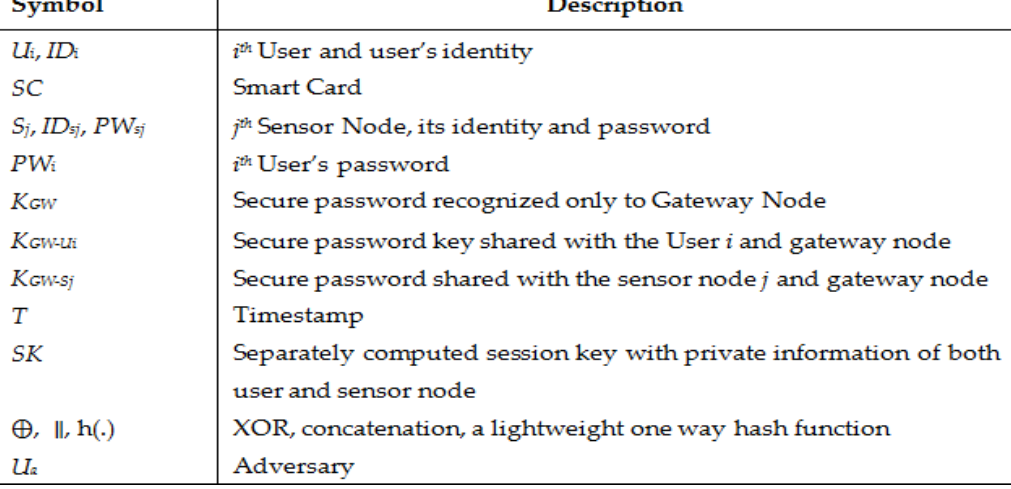
Figure 2. Registration phase of Singh et al.’s scheme. 3.1.1. Registration Between User and Gateway Identity ( ID i ) and secure password ( PW i ) are provided to every user. User identity and password hash value are saved in the gateway node. At first, the gateway selects a random key K GW-U . With this key, GW can communicate with the user. The gateway fur- ther selects a different key K GW-S . With this particular key, GW can communicate with sensor nodes. The procedure for this phase is as follows: Step-1: User U i selects a random number r i and computes P i = h ( r i || h ( PW i )). Step-2: User generates time stamp Ts 1 and sends { P i , ID i , Ts 1 } to GW through a pro- tected channel. Step-3: Following the received message, the gateway verifies the legitimacy of a time stamp. If | T S 1 − T c | < ∆ T exists, then gateway calculates. • α i = h ( K GW-U || ID i ); •